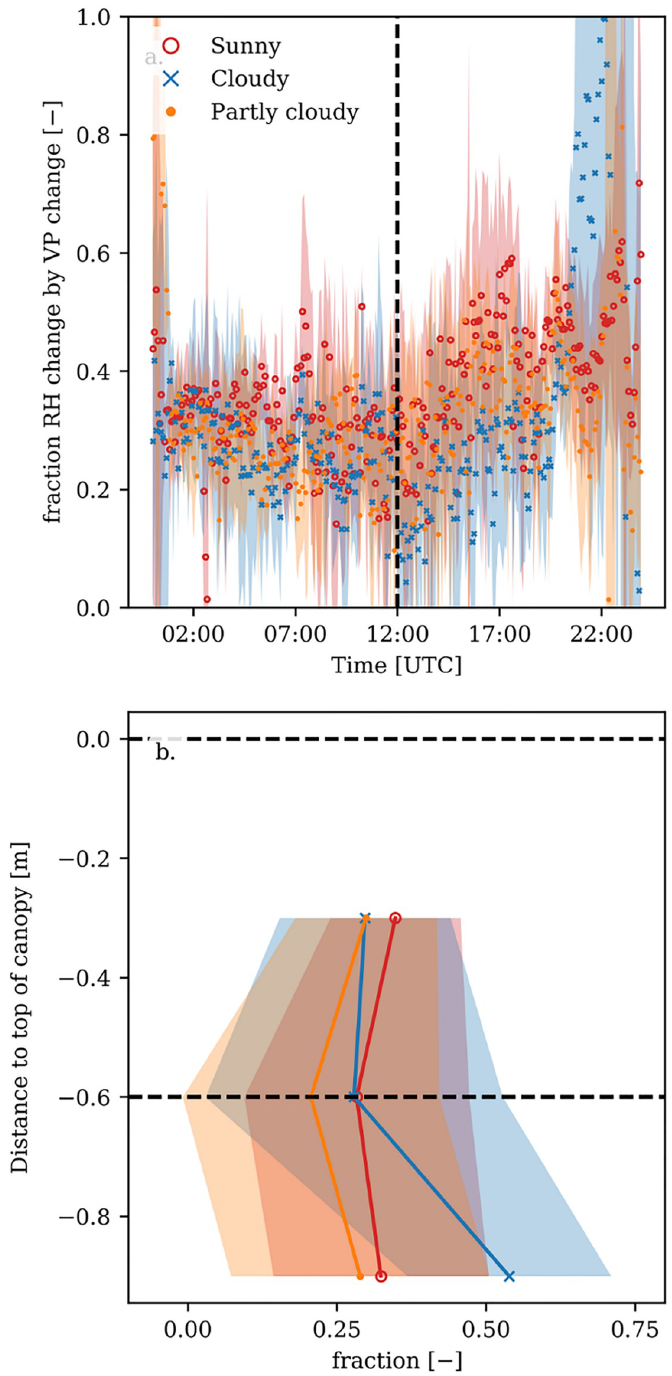
Fig 5. Fraction of the difference between ambient relative humidity ( RH ) and canopy relative humidity (i.e. RH of the air 60 cm below the top of the canopy) that is determined by the change of water vapour pressure. Fraction of the RH difference determined by changes in water vapour pressure (bold lines) for sunny (red), cloudy (blue) and partly cloudy days (orange). The shaded area represents the standard deviation. (a) time course of the fraction, where the dashed line indicates noon. (b) vertical profile of the fraction in the canopy at noon; the dashed lines show the heights at which the fraction between ambient and canopy RH explained by the change of water vapour pressure were